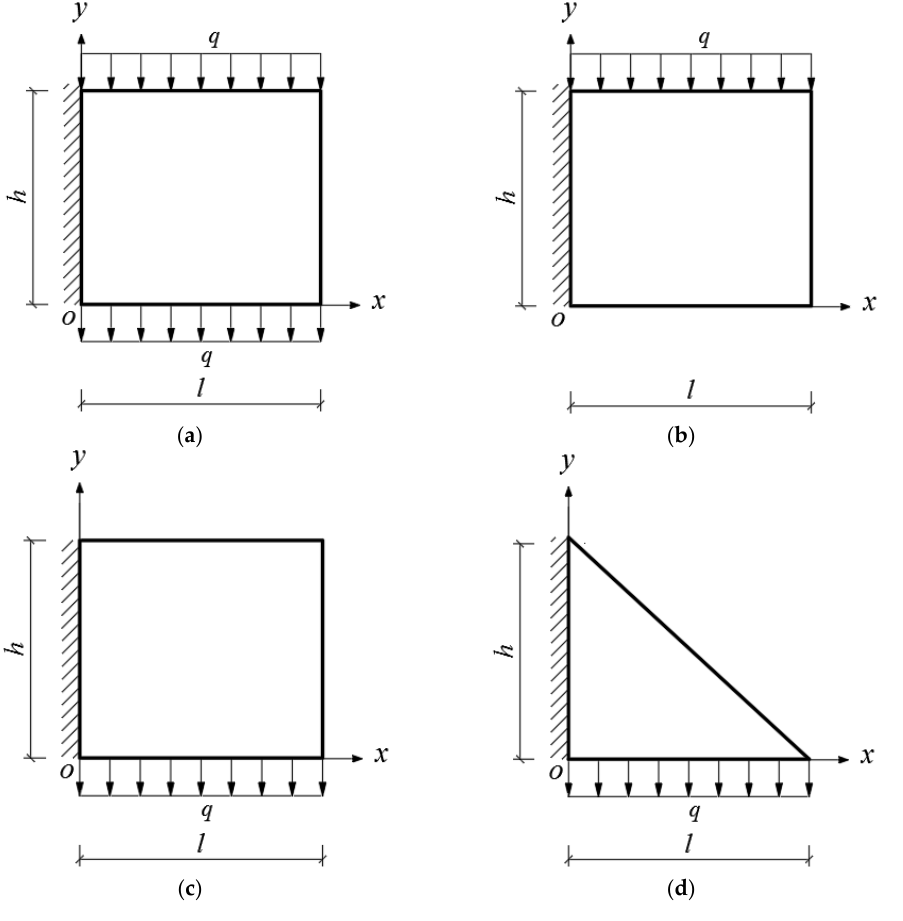
Figure 2. Four stability problems with bimodular effect: ( a ) Rectangular cantilever vertical plate with top and bottom loaded, ( b ) Rectangular cantilever vertical plate with top loaded, ( c ) Rectangular cantilever vertical plate with bottom loaded and ( d ) Triangular cantilever vertical plate with bottom loaded.